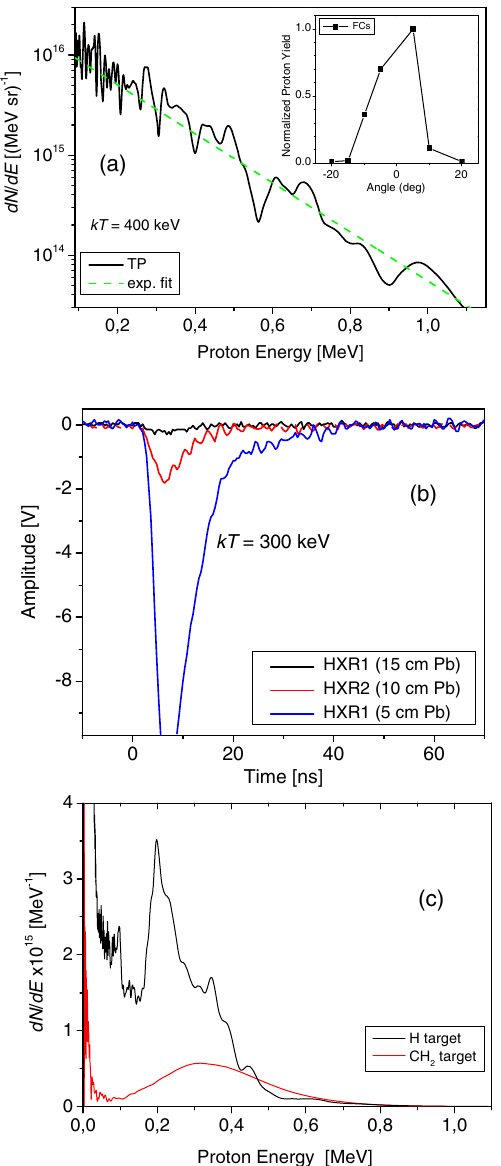
FIG. 7. (a) Proton energy distribution measured with TP (black line) and linear fit (dashed green line) along with the ion angular distribution measured with FCs (see inset). (b) HXR signals measured with the three detectors having different Pb filter thickness (the signal recorded by the detector with a 5-cm Pb shielding is saturated; however, an extrapolation of the signal is used to calculate the hot electron temperature). (c) Proton energy distribution recalculated from TOF spectra acquired with solid-H and CH 2 targets in similar laser irradiation